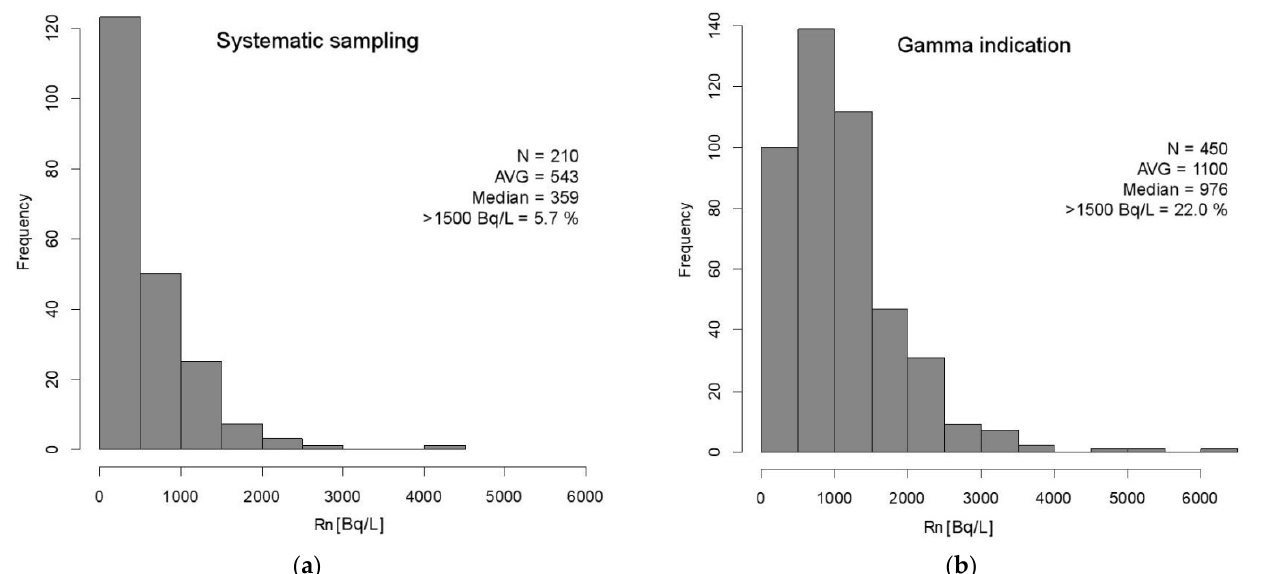
Figure 17. Histograms of water activity distribution of the parts of the data set where the activity was not or could not be measured, representing classical systematic sampling ( a ) and where gamma activity was measured representing the gamma indication method ( b ).